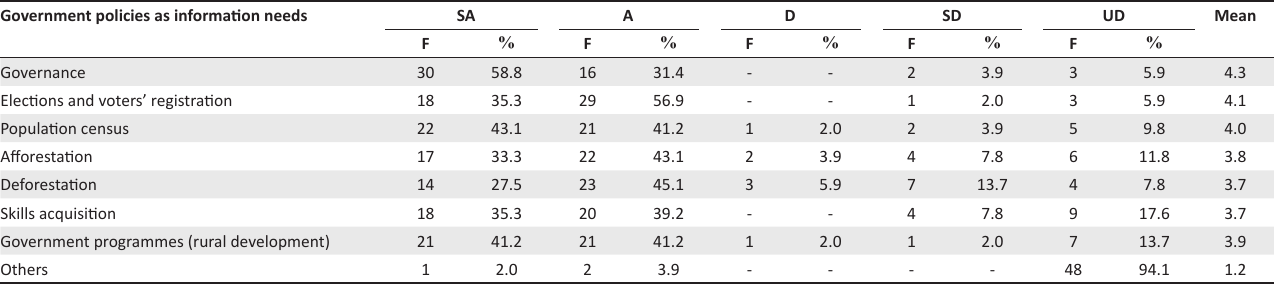
TABLE 7: Opinions of the heads of branch libraries on information needs of the rural dwellers on government policies ( N = 51). Government policies as information needs